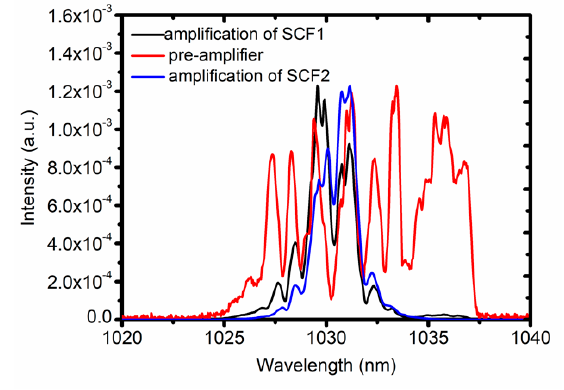
Figure 6. Spectrum measurement of different amplified power outputs.